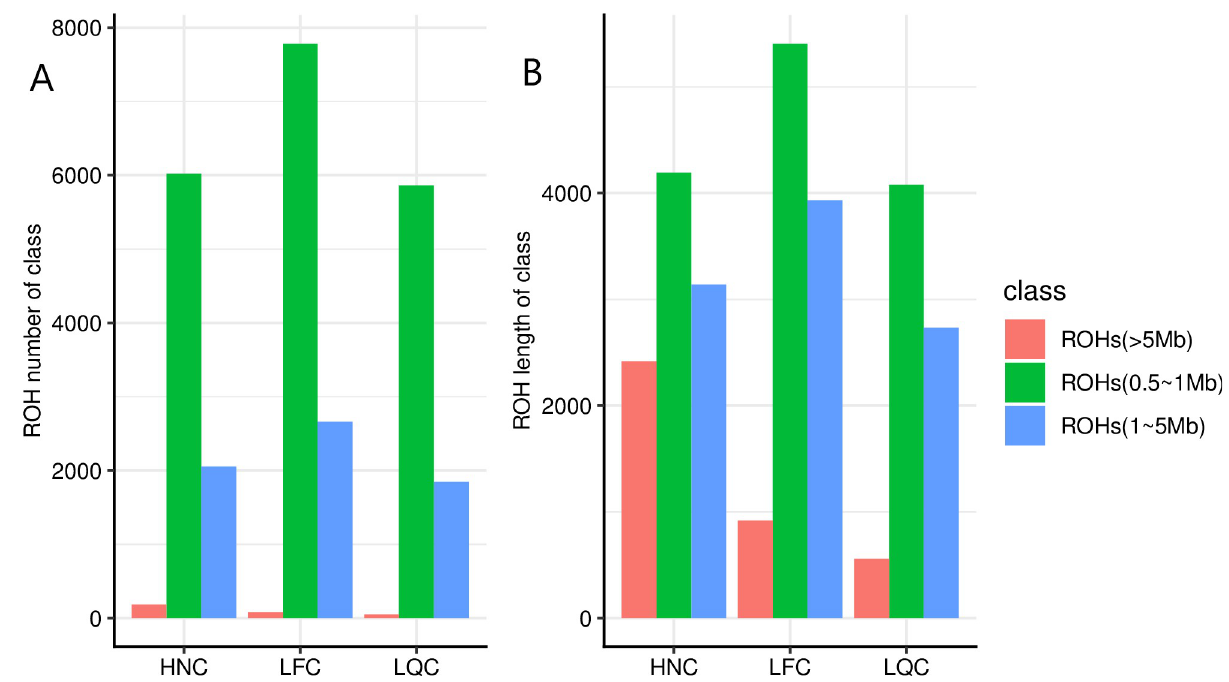
Fig 2. Total length and number of ROH for three size classes including Small (0.5 to 1 Mb), Medium (1 to 5 Mb) and Large ( > 5 Mb). (A) The total number of ROH for size classes. (B) The total length of ROH for three size classes. LQC: Leiqiong cattle; LFC: Lufeng cattle; HNC: Hainan cattle.